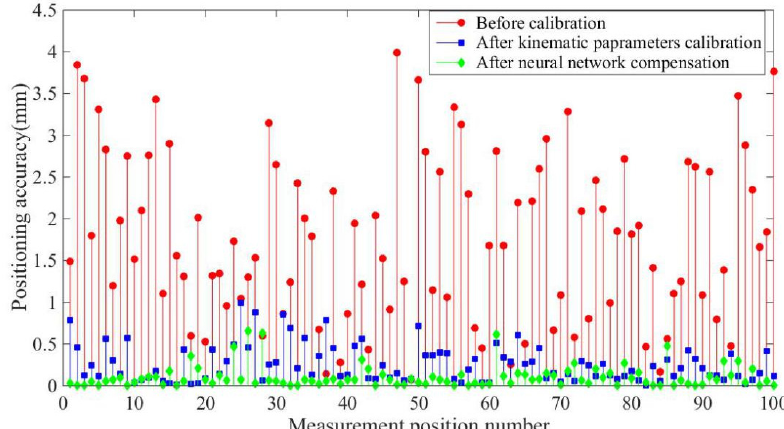
Sensors 2020 , 20 , x Figure 13. Positioning accuracy of the experiments. Figure 13. Positioning accuracy of the experiments.